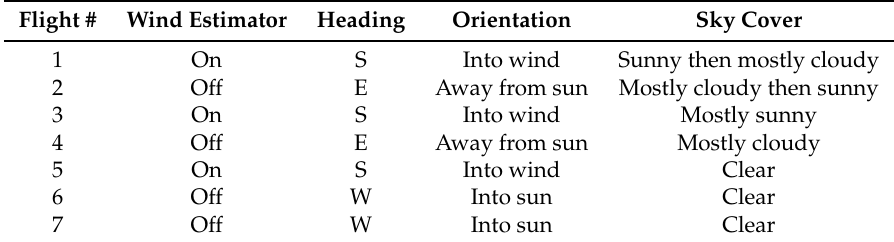
Table 2. Description of the 7 CopterSonde flights on 13 September 2018 at KAEFS. The wind was primarily from the south and southeast for the duration of these flights (Figure 4). When the wind estimator was “off”, the CopterSonde yaw angle was controlled manually. Flight # Wind Estimator Heading Orientation Sky